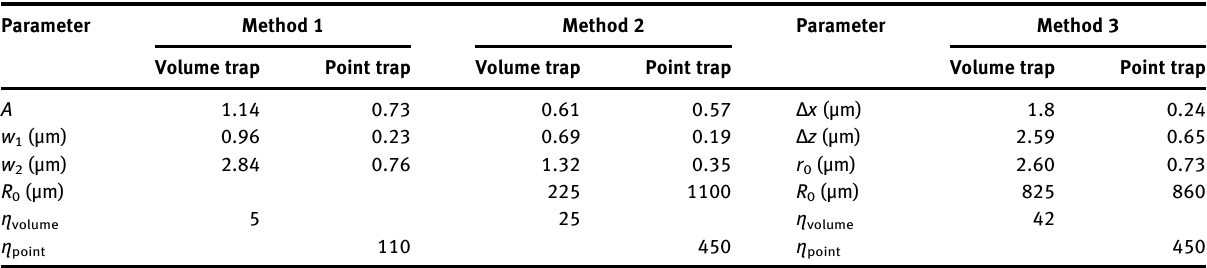
Table  : Values of the parameters that were used to generate the bottle-beam traps shown in Figure  a – f. All traps are generated at λ  = 